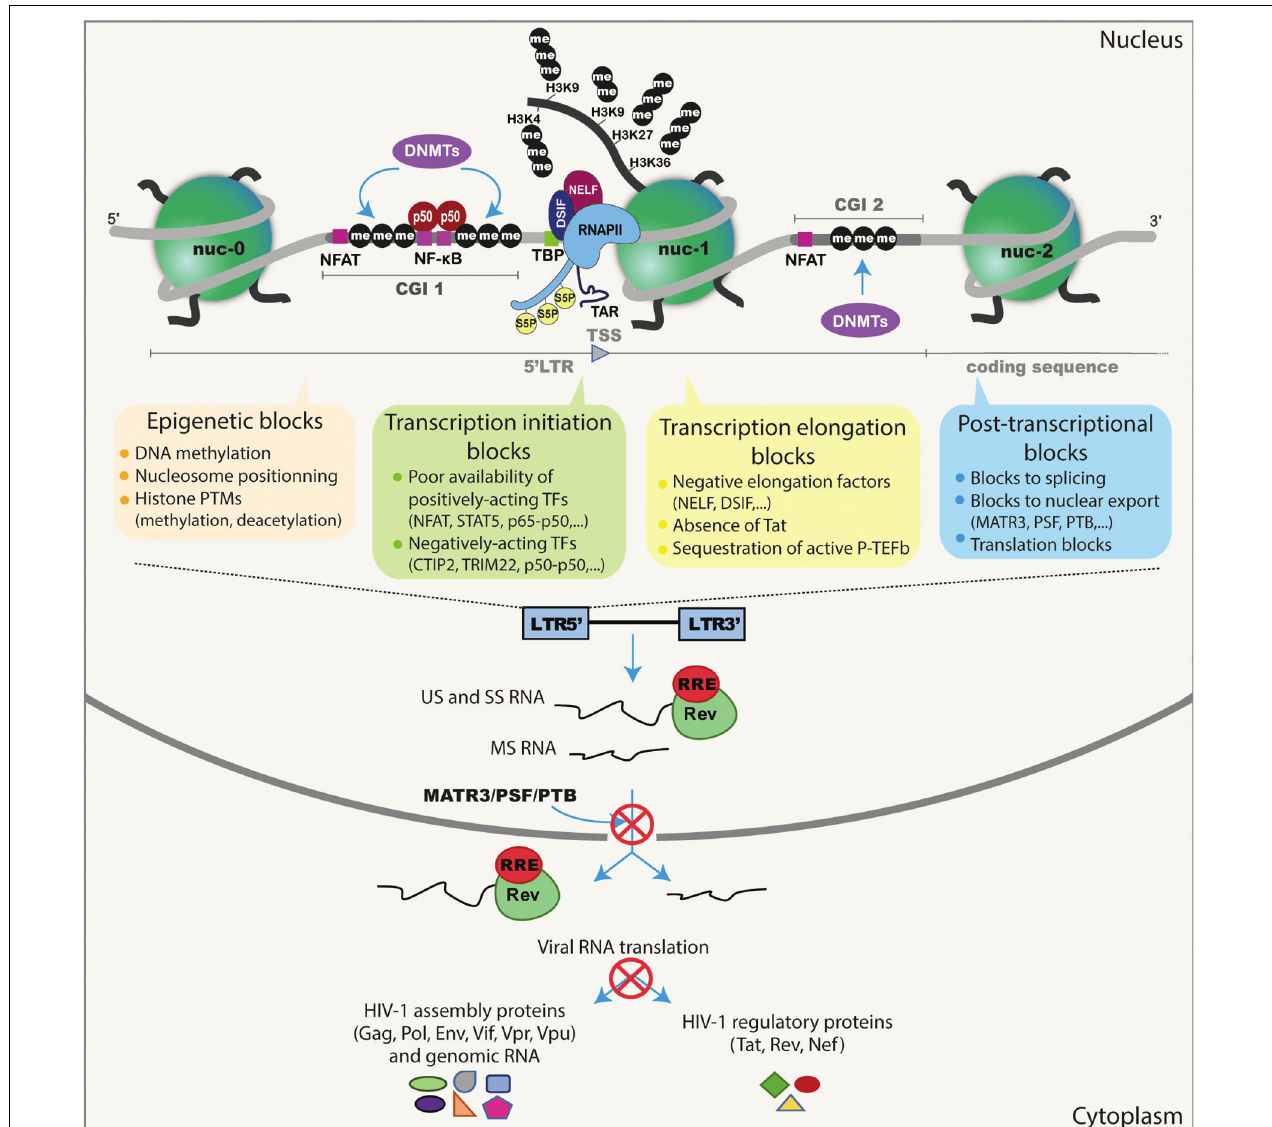
FIGURE 1 | Schematic representation of the different transcriptional and post-transcriptional blocks involved in HIV-1 latency. During HIV-1 latency, several blocks preventing viral production have been described. These are represented by the methylation of the two CGIs surrounding the HIV-1 TSS and the deposit of repressive epigenetic marks (histone deacetylation and methylation) maintaining the repressive nucleosome nuc-1 positioned in the HIV-1 5 (cid:48) LTR promoter just downstream the TSS. The transcription initiation is also blocked because of the cytoplasmic sequestration of the positive NF- κ B heterodimer p50–p65 and the phosphorylated NFAT and STAT5. The presence of repressive factors (such as CTIP2, TRIM22 and the binding of the homodimer p50–p50 to the NF- κ B binding sites in the HIV-1 promoter) acts negatively on HIV-1 transcription initiation. The RNAPII, with its phosphorylated serine 5 (S5P) residue in its C-terminal domain, pauses and accumulates at the promoter-proximal region due to the binding of the negative factors NELF and DSIF. The elongation is also blocked by the absence of the master regulator of viral transcription Tat and by the sequestration of the positive transcriptional elongation factor P-TEFb into the inactive complex named 7SK snRNP. The splicing and export of HIV-1 transcripts are inefficient during latency due to the low expression level of post-transcriptional factors such as PTB, MATR3, and PSF. Finally, translation of viral transcripts could be inhibited by mechanisms involving mRNA degradation and sequestration in cytoplasmic granules.